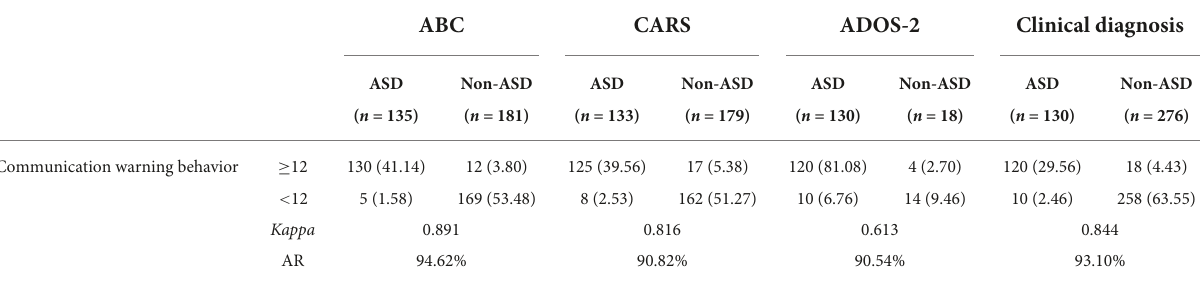
TABLE 5 Consistency between the communication warning behavior (cutoff value = 12) of CNBS-R2016 and ABC, CARS, ADOS-2, and clinical diagnosis for the classification of ASD. ABC CARS Clinical diagnosis ASD Non-ASD ASD Non-ASD ASD